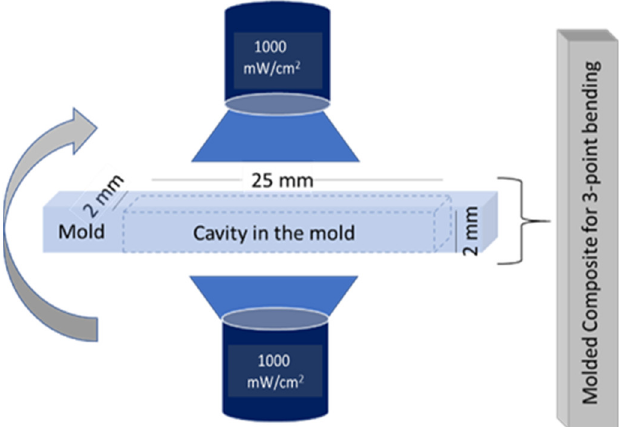
Figure 2. Composite sample curing process.